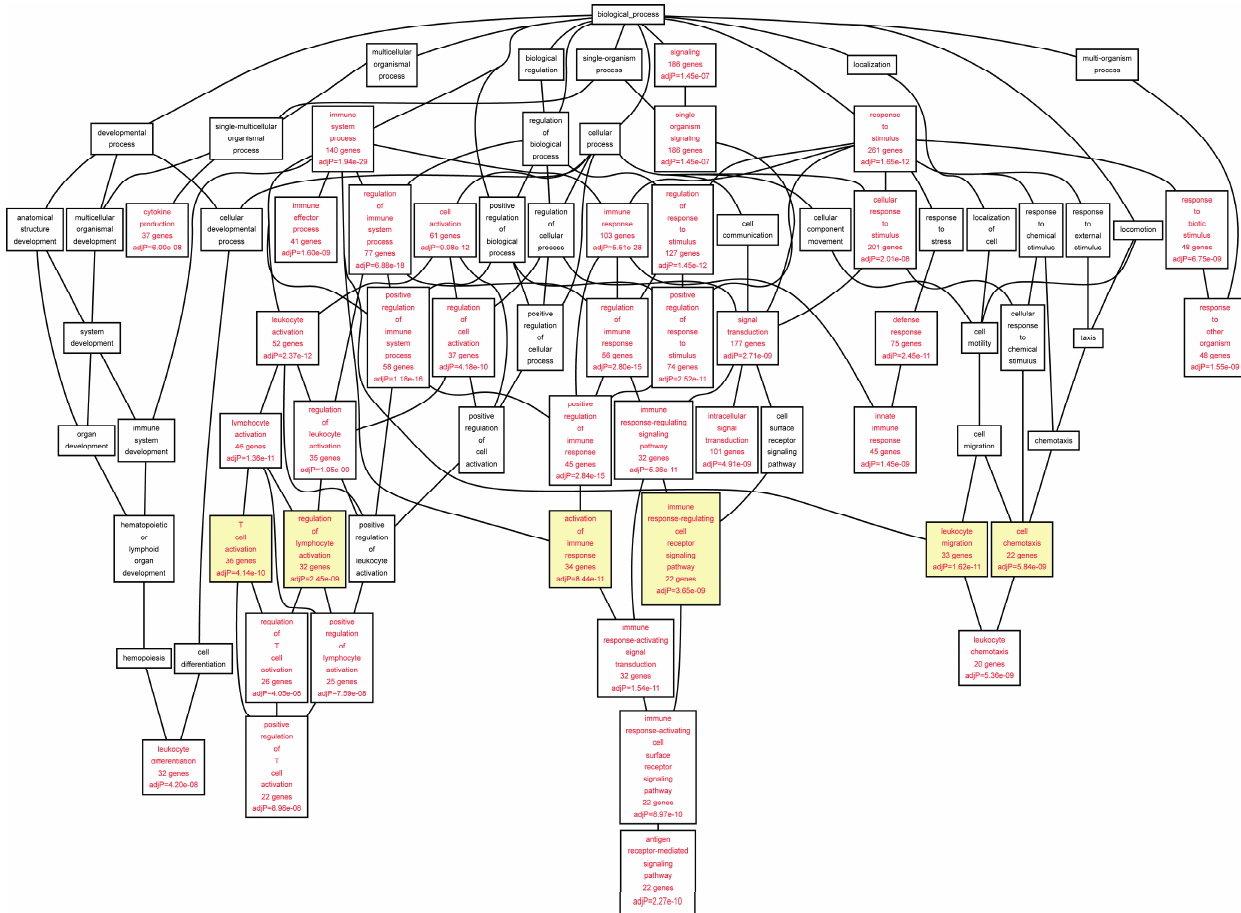
Figure 4. Biological categories of the up-regulated target genes of transcription factors RUNX1, ELF1, ETS2 and STAT5 in the AAA tissue. A DAG of the GO categories of the set of 395 genes was generated by the web application WebGestalt [32]. Categories shown in red were significant (adjusted p < 0.001). The categories on the 6th level of hierarchy are discussed in the text and are shown here with a yellow background. See Tables 7 and S6 for additional